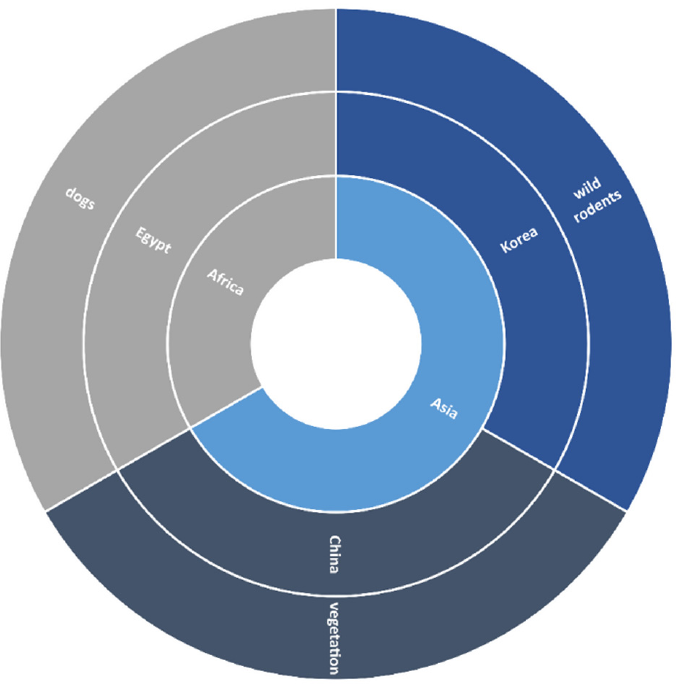
Figure 6. Number of studies on the basis of site of tick collection in Asia and Africa. As with other tick species, climate change also exerts effects on the expansion of I. scapularis distributions; this is reported to be increasing where warmer conditions are prevailing [82], supporting claims of higher risks of Lyme disease in these areas in the future. Two studies have been conducted in North America which found B. burgdorferi in ticks collected from pets (cats and dogs), and in one study conducted in Ontario, Canada, pathogen-positive tick samples were collected from both humans and companion ani- mals, reporting prevalence of the pathogen in I. scapularis at 17.5% and 9.9% respectively. The presence of ticks on companion animals is a significant risk factor for spread of the pathogens they carry. Studies considered in this review revealed the presence of B. burgdor- feri carrying I. scapularis on pets, which is not only a source of transmission of B. burgdorferi to the pets themselves, but also poses a threat to humans with regard to Lyme disease transmission. The increasing population of black-legged ticks is also contributing to the transmission of other zoonotic pathogens such as Anaplasma phagocytophilum, Babesia microti, Powassan virus, and Ehrlichia muris [76]. In North America, this expansion of